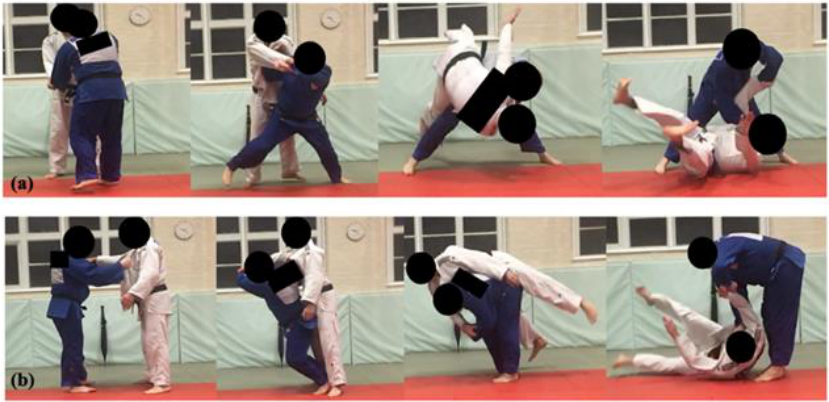
Figure 2. Four-step movement sequence of tori (blue) throwing uke (white) in: ( a ) tai-otoshi and ( b ) morote-seoi-nage.